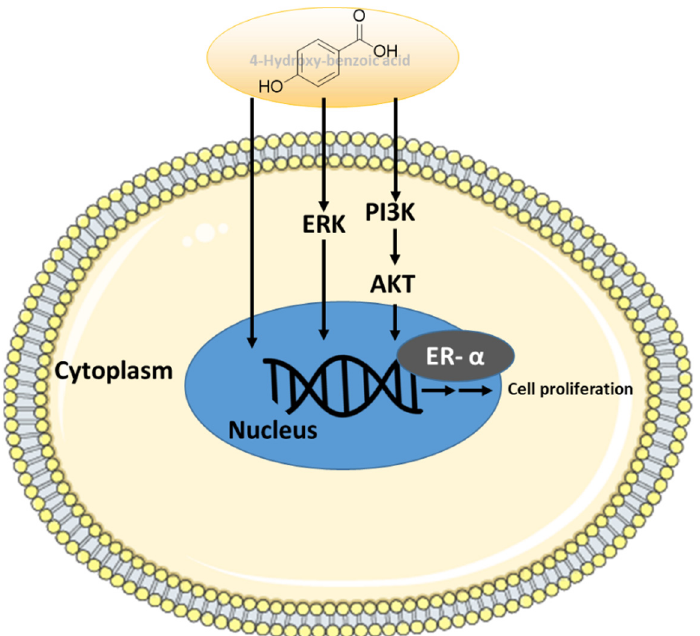
Figure 6. Schematic illustration of the mechanism underlying the estrogenic activity regarding to 4-hydroxy-benzoic acid via ER α -dependent signaling pathways in the ER-positive breast cancer cells (MCF-7).